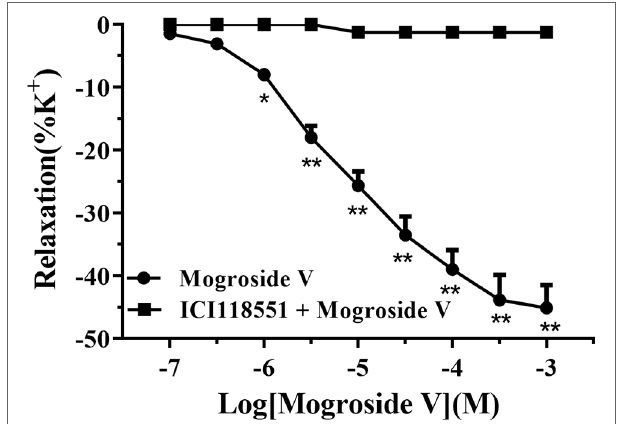
FIGURE 5 | The dose–response curves of mogroside V for the relaxation effect on rat tracheal smooth muscle pre-contracted by high K + solution (60 mM) in vitro . Each point represents the means ± SEM of each group (n = 6) from two separate experiments. * p < 0.05, ** p < 0.01 versus the ICI 118551 treated